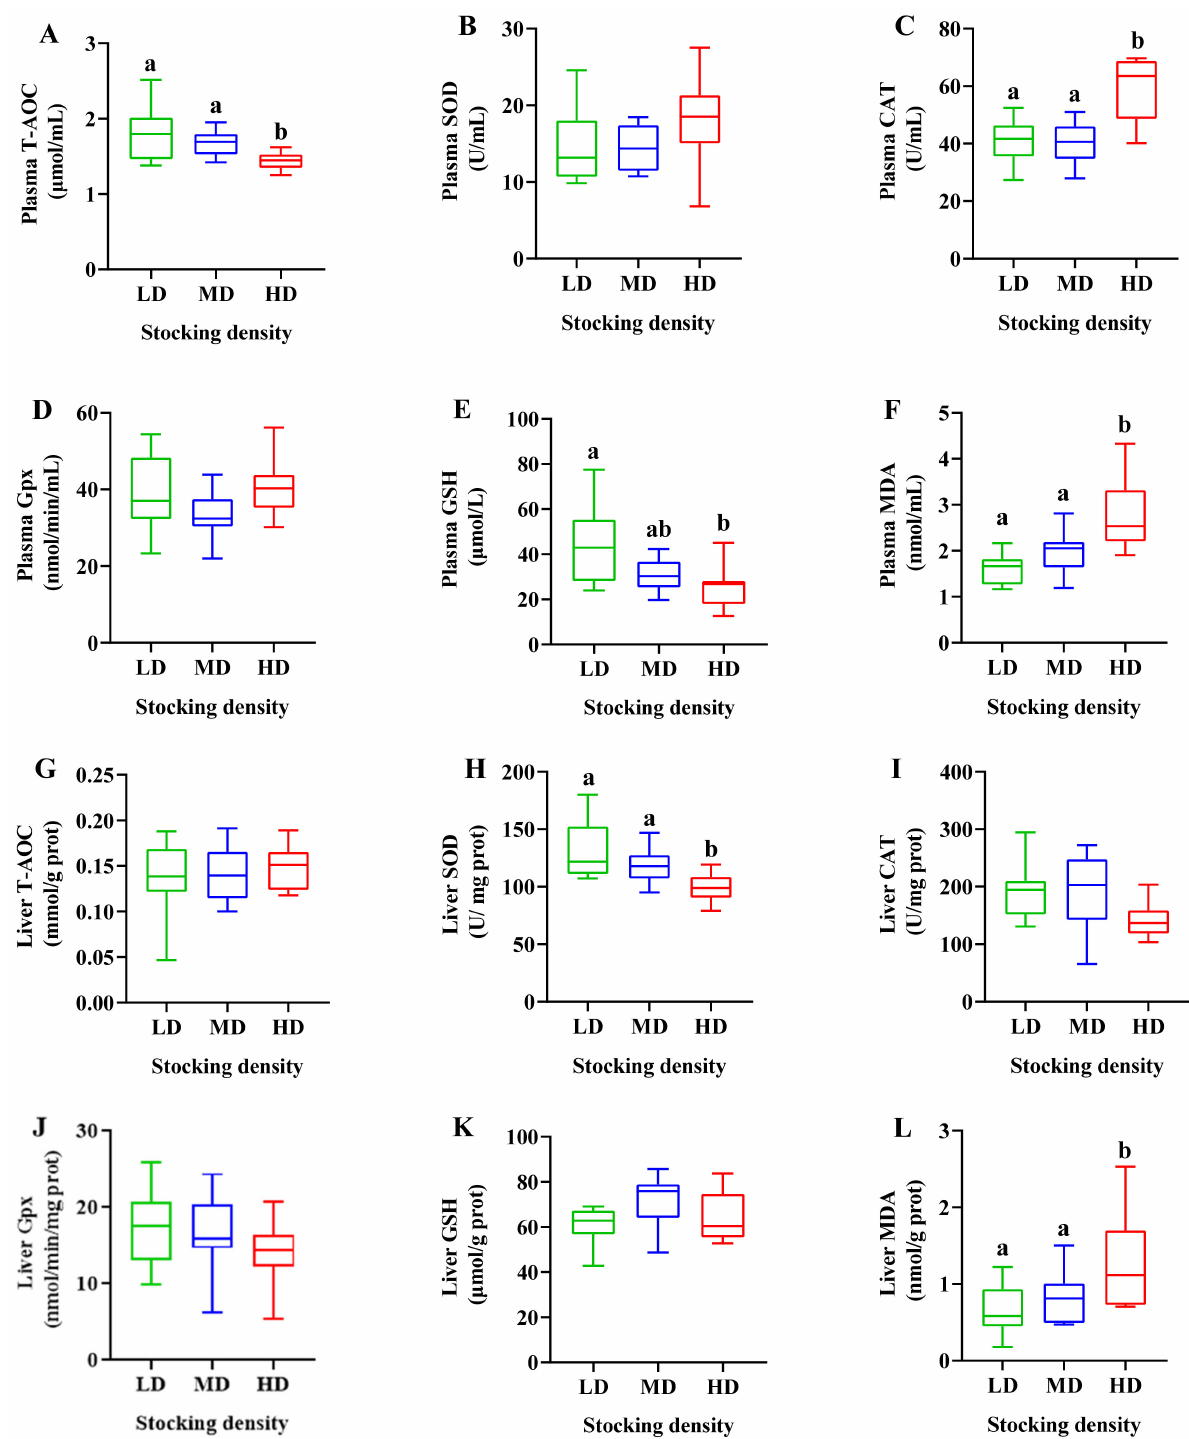
Figure 2. Antioxidative parameters in the plasma ( A – F ) and liver ( G – L ) of M. salmoides reared at different densities in an integrated rice–fish farming system after 90 days of farming. Values are expressed as means ± SEM, n = 12. Different letters as superscripts indicate a statistical significance among different densities ( p < 0.05). LD, low stocking density; MD, medium stocking density; HD, high stocking